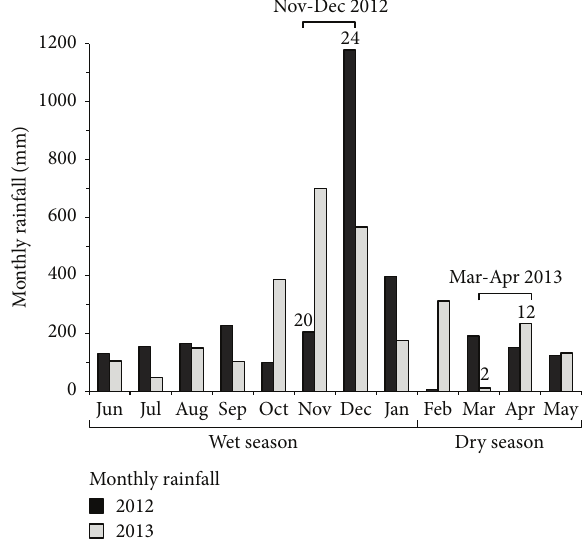
Figure 2: Monthly rainfall data for a period of two consecutive years, 2012-2013. Difference in the monthly rainfall (millimeters) was observed during which the Aedes larval surveys were conducted between wet season (November-December 2012) and dry season (March-April 2013). Also, the numberings inside and outside the bars indicate rainfall days that were observed during the studied months of wet season, November (20) and December (24), and of dryseason,March(2)andApril(12),respectively.Thesemeteorolog- ical data were obtained from the Narathiwat Meteorological